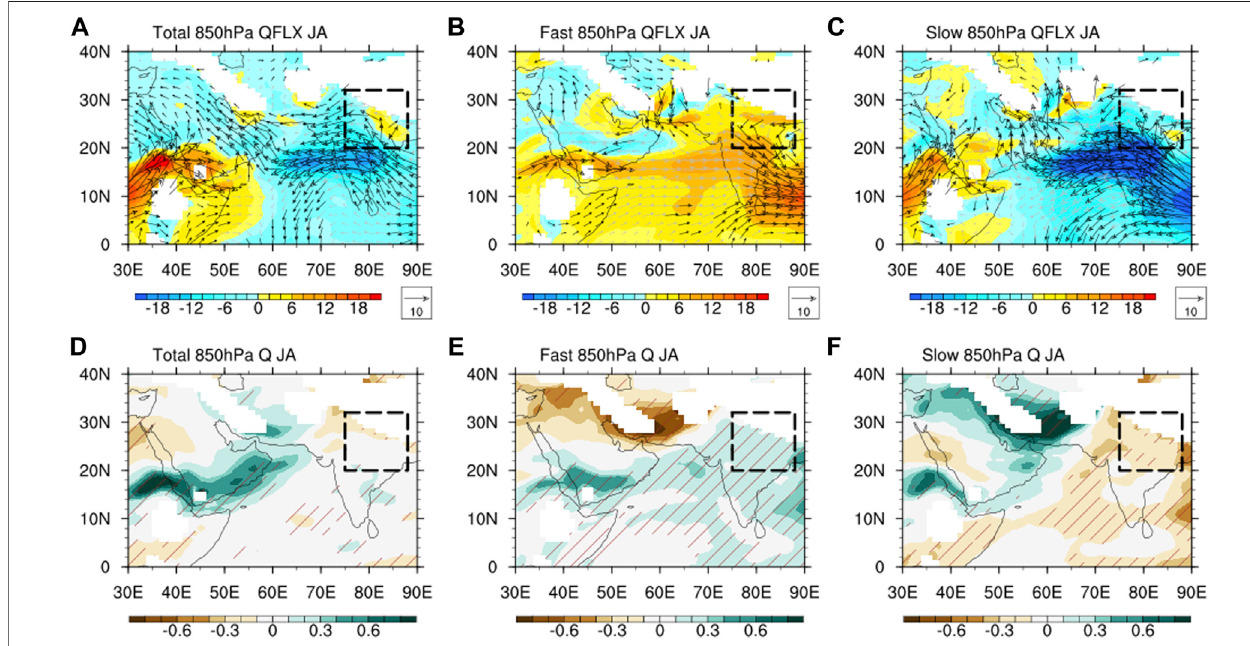
FIGURE13| The total [ (A,D) , CMD − CMN], fast [ (B,E) , UMD − UMN]and slow [ (C,F) (CMD − CMN) − (UMD − UMN)] responsesofmoisture fl ux[ A – C ; g/(hPam s)]and speci fi c humidity ( D – F , g/kg) at 850 hPa to the dust DRE during the late monsoon season (July – August). Black (grey) arrows represent the moisture fl ux vector differences statistically signi fi cant (insigni fi cant) at the 0.1 level. Brown lines represent the values statistically signi fi cant at the 0.1 level.